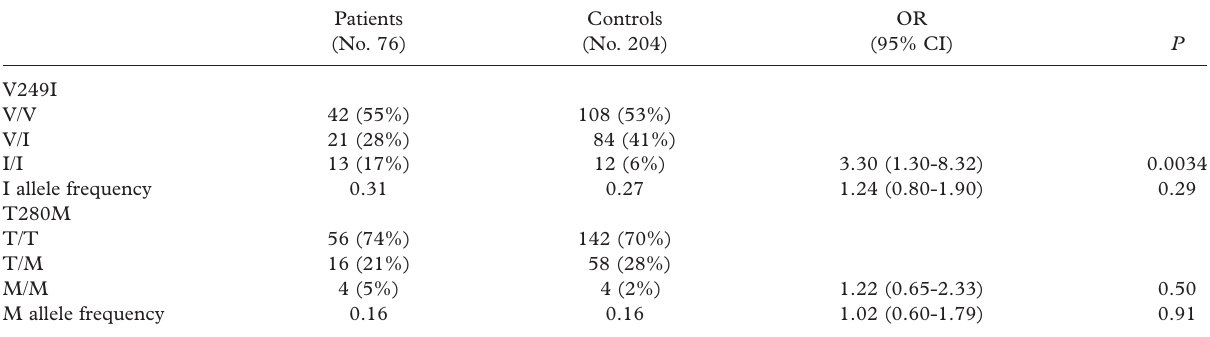
Table I. Odd ratios for genotypes were calculated with V/I þ V/V vs I/I and T/M þ T/T vs M/M. Patients (No. 76)